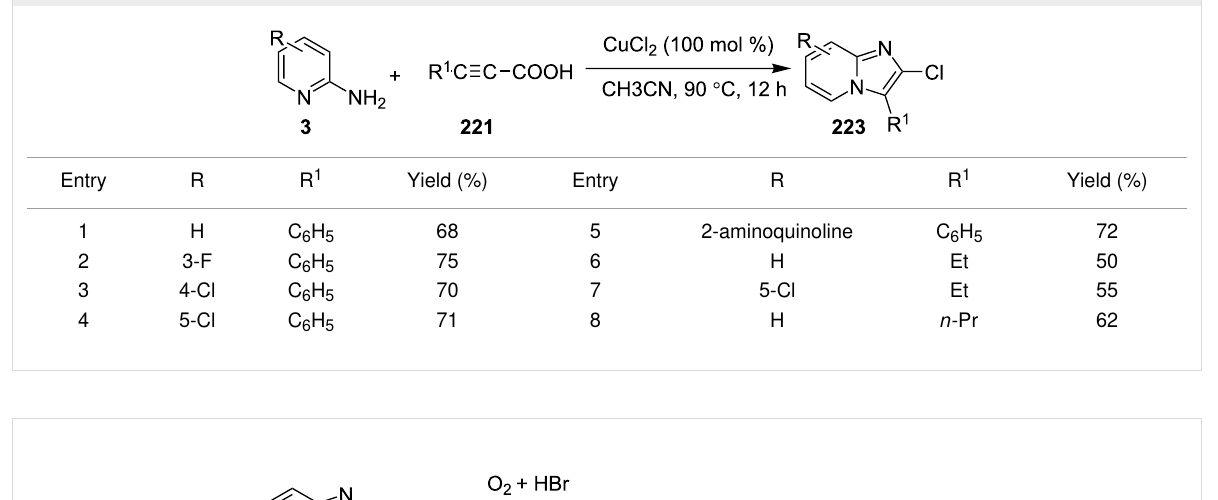
Table 7: Use of copper chloride as halogenating